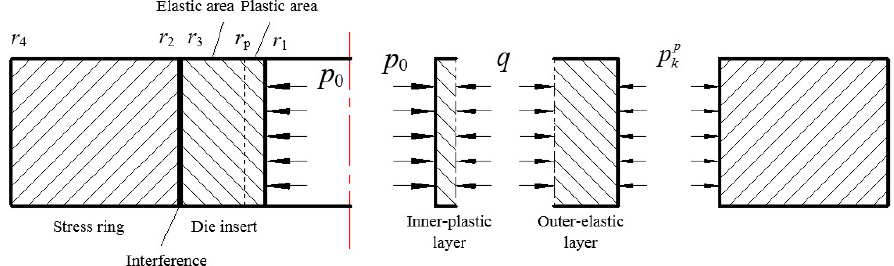
Figure 1. Double-layer combined die.